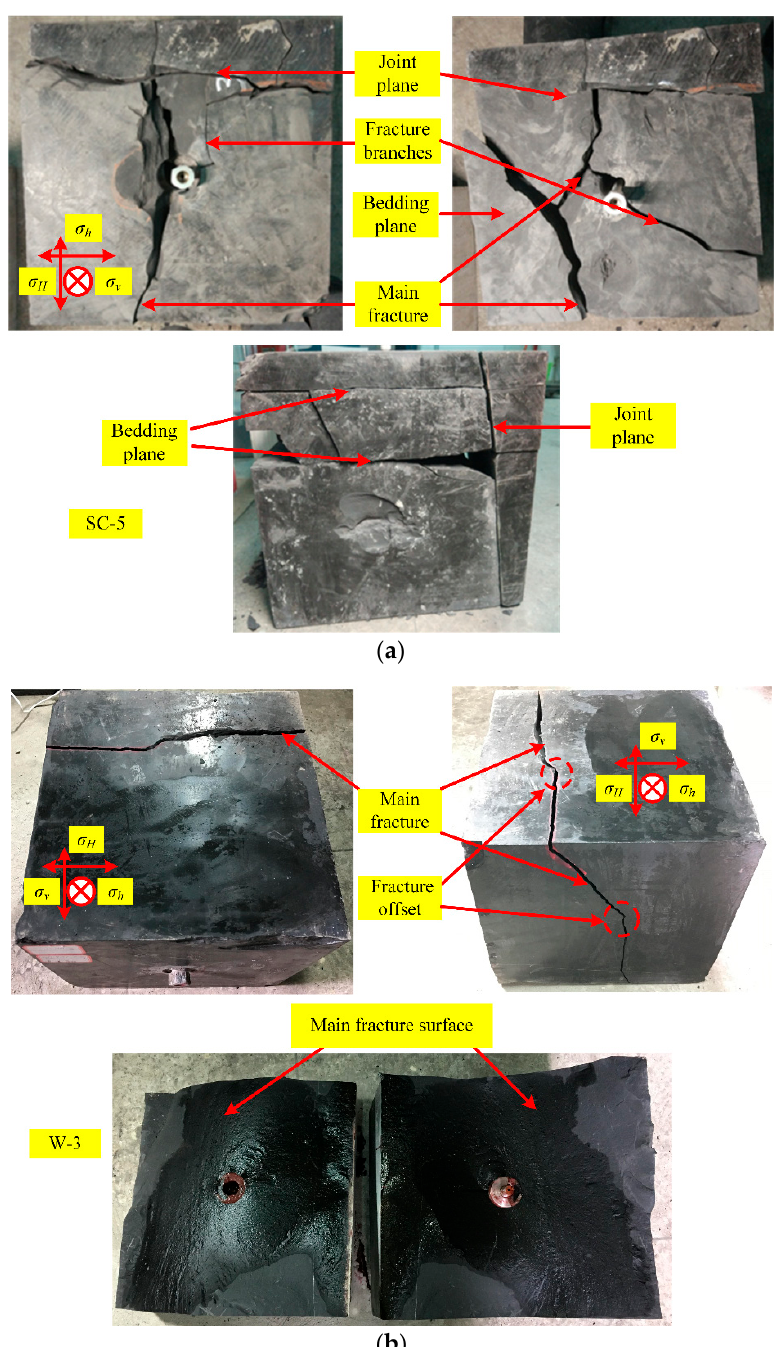
Figure 6. Comparison of fractures propagation and morphology in shale between SC-CO 2 induced fractures and water induced fractures. ( a ) SC-5: Shale fractured by SC-CO 2 . The upper broken rocks were removed from the top left to right images; ( b ) W-3: Shale fractured by water.